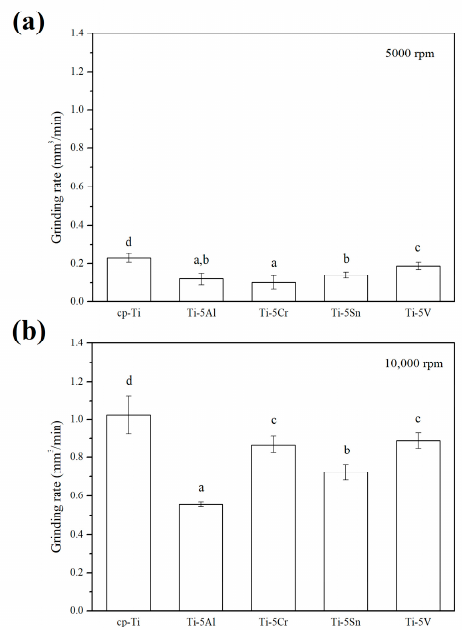
Figure 4. The grinding rates of cp-Ti and Ti alloys ground using an SiC wheel at revolution speeds of 5000 rpm and 10,000 rpm ( n = 7). The superscript alphabets of ( a ) a–c and ( b ) a–d indicate significant differences at the p = 0.05 level according to Duncan’s multiple range tests. The mean values with the same superscript alphabet are not statistically different ( p > 0.05).